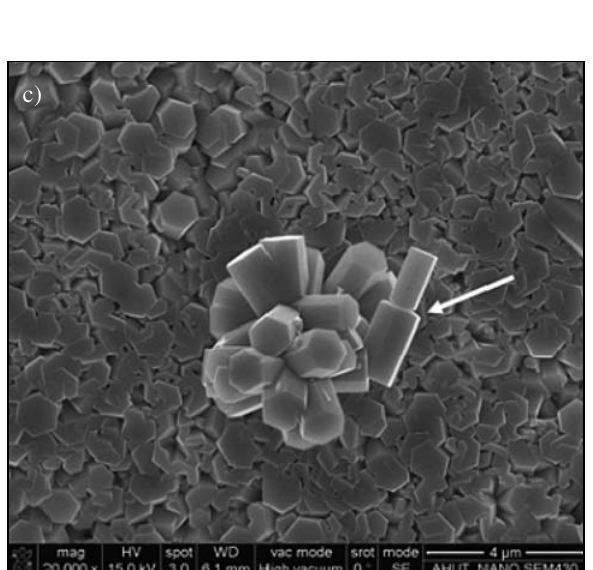
/Si; (c) The typical SEM images of 2